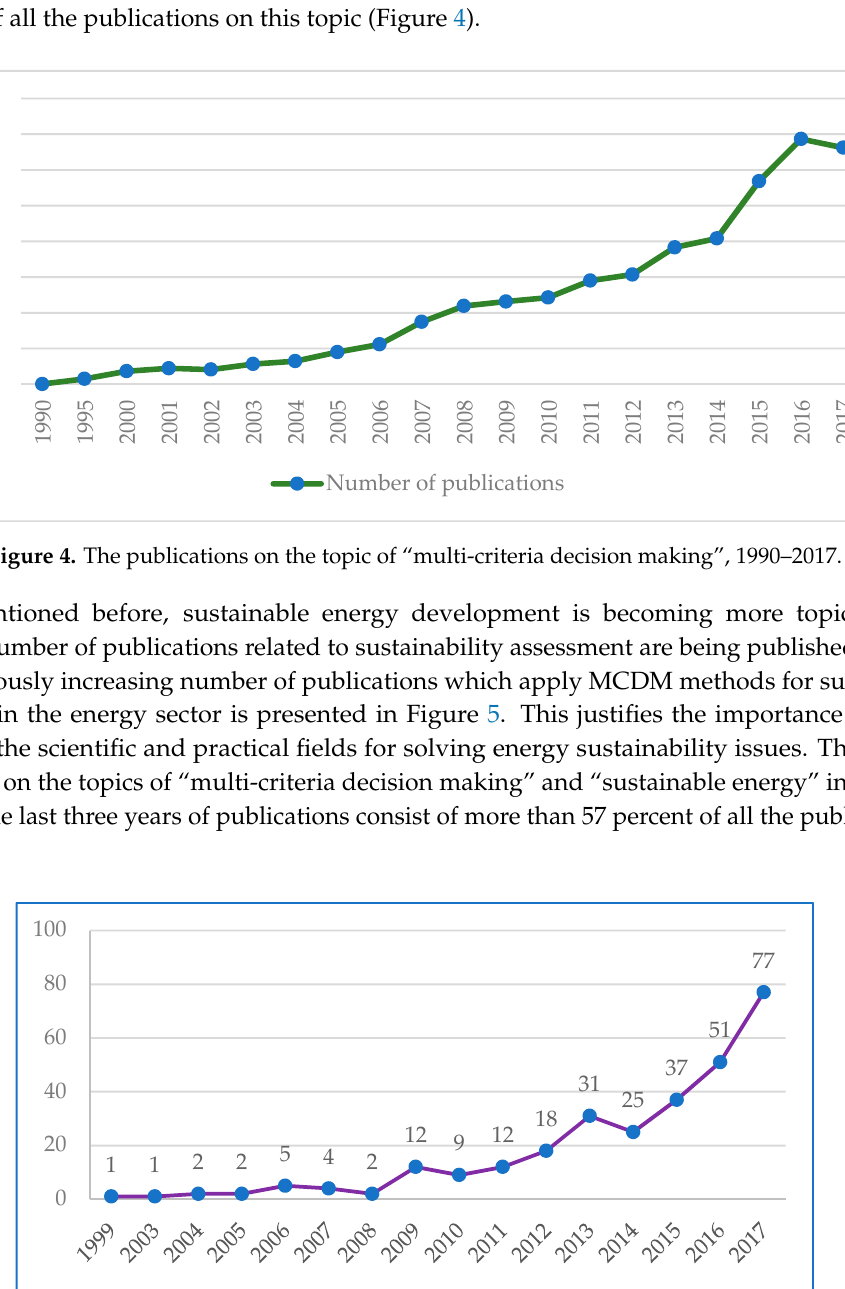
Figure 3. The publications on the topic “sustainable energy”, 1990–2017.